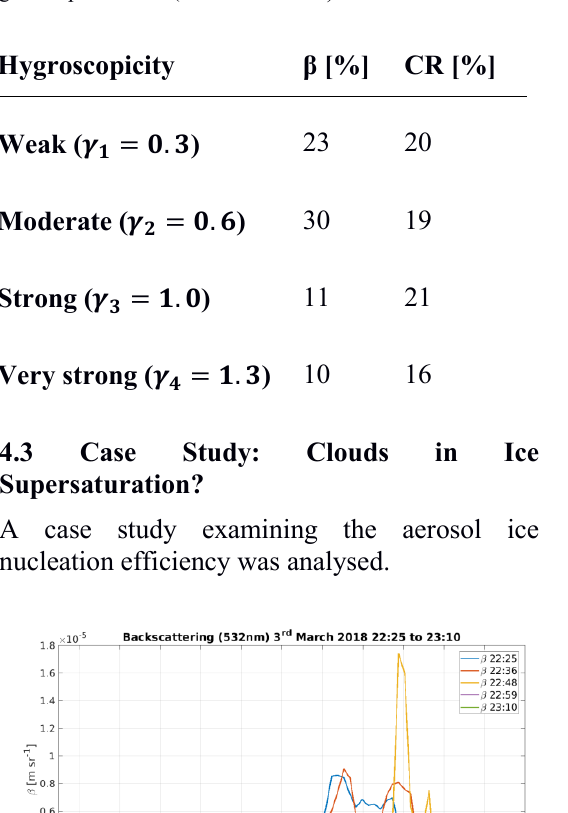
Tab. 01 : Distribution of backscatter and CR for different growth parameters (for ) .